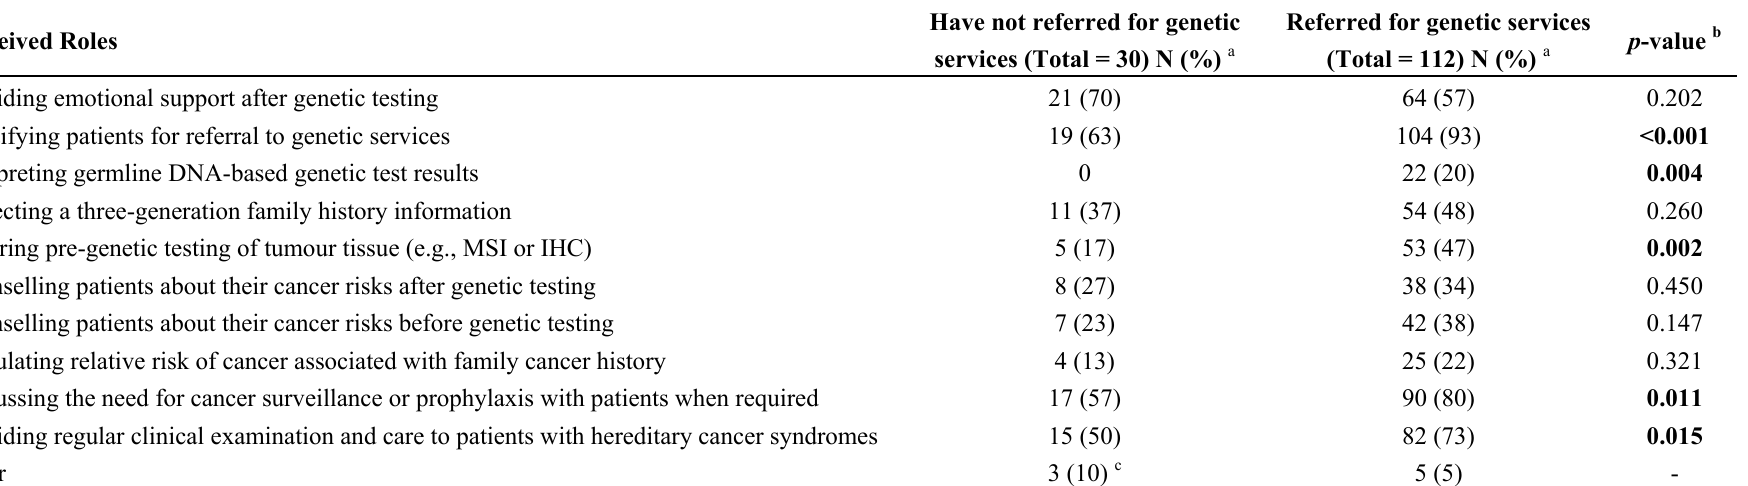
Table 4. Clinicians’ perceived roles and referral of patients suspected with Lynch syndrome genetic services